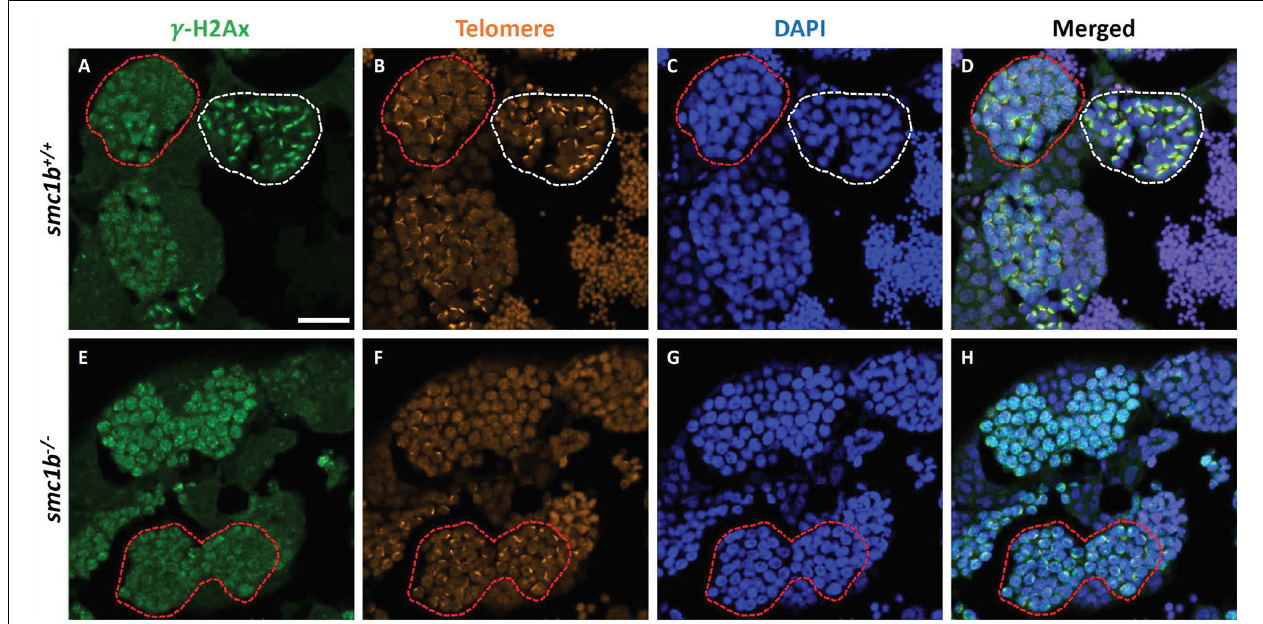
FIGURE 7 | DNA double strand break marker γ -H2Ax was expressed in smc1b Q198X mutant testes. Immunolabeling of γ -H2Ax (green) and Telo-FISH (orange) on wild-type and mutant testis sections. (A–D) In wild-type early bouquet stage spermatocytes, γ -H2Ax appeared to localize more broadly in nuclei on testis sections (red dashed lines). Bouquet stage spermatocytes with tightly clustered telomeres (white dashed lines) exhibited γ -H2Ax localization near telomeres. (E–H) Early bouquet-stage spermatocytes in s mc1b mutants display broad γ -H2Ax expression similar to wild type, however, tight clustering of telomeres and γ -H2Ax to one side of the nucleus was not observed. Scale bar is 20 µ